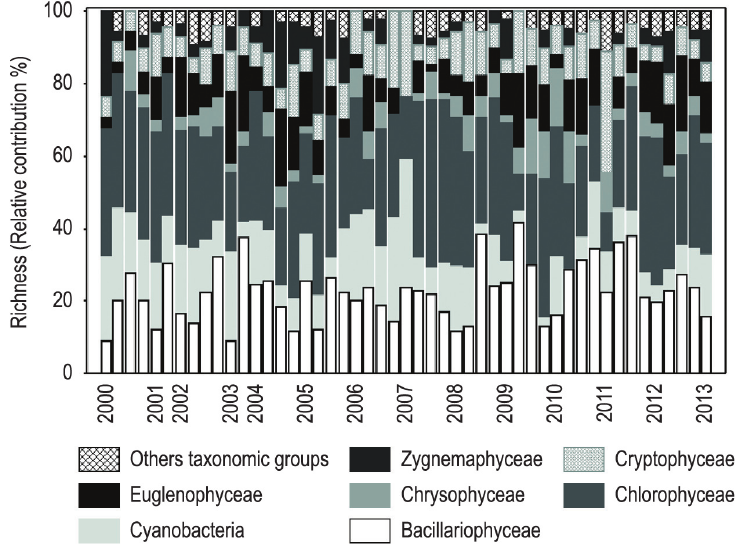
Figure 4. Interannual variation in the relative contribution of phytoplankton groups for richness in the floodplain